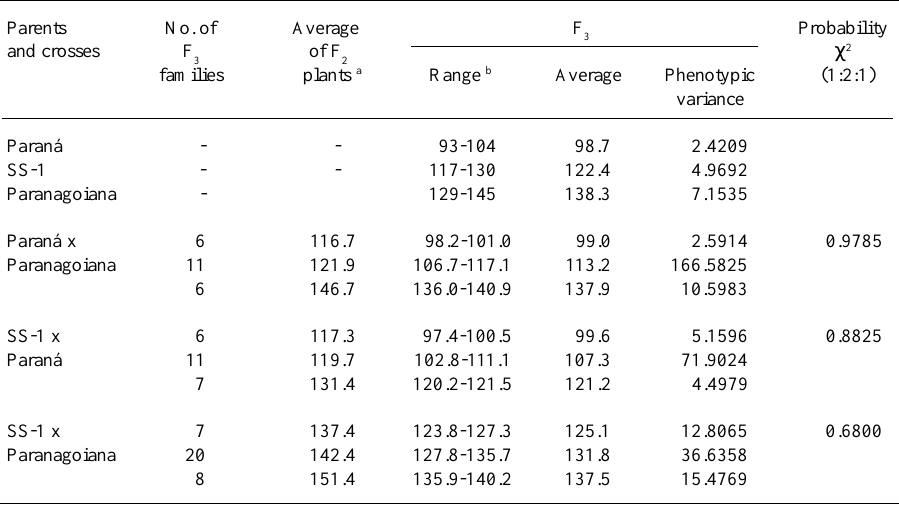
Table II - Classification of F soybean families according to the average of F 3 phenotypical variance of number of days to maturity in comparison to the parents of crosses Paraná x